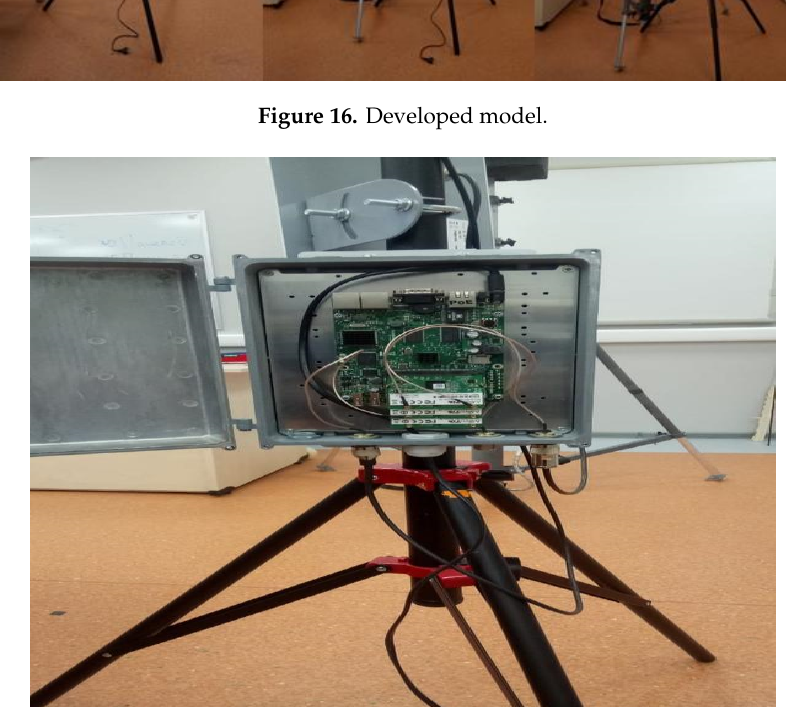
Figure 17. Used Figure 17. Used devices.